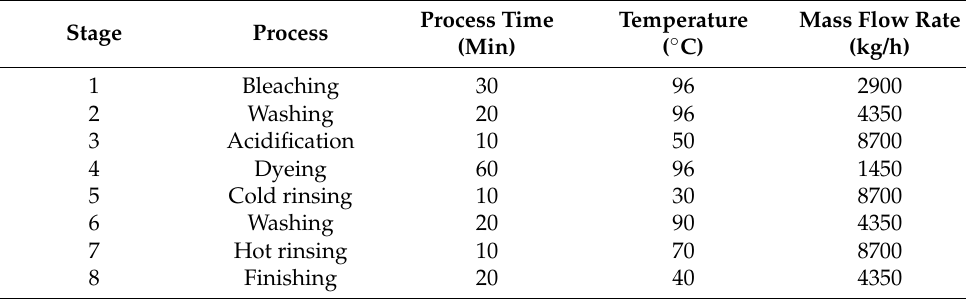
Table 2. Process design